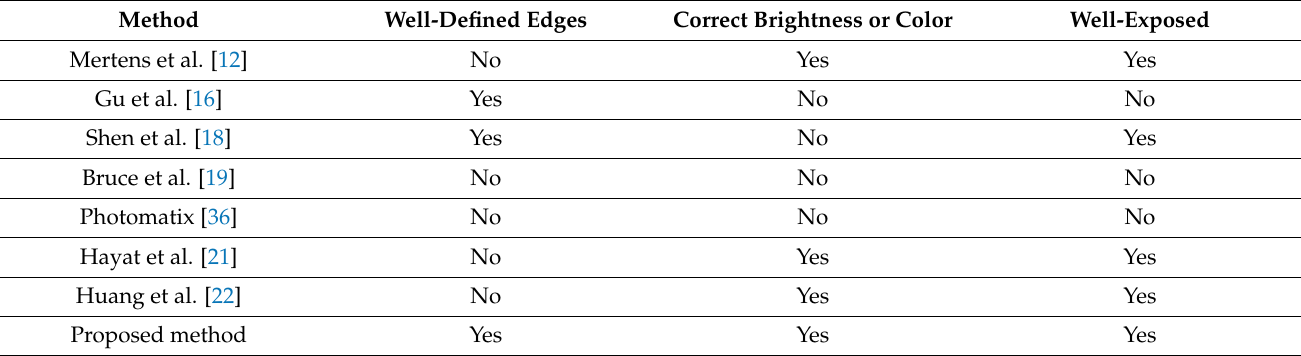
Table 3. Detailed comparison of Figure 6.